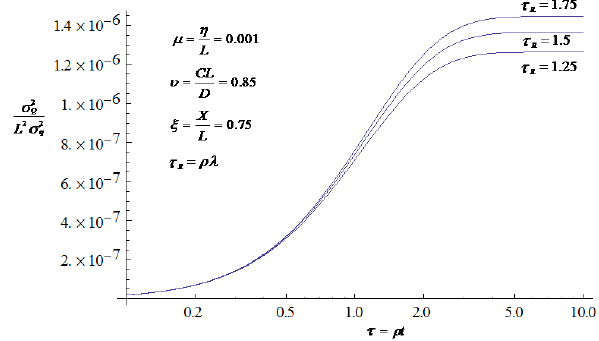
Figure 2. Dimensionless variance of discharge fluctuations as a function of dimensionless time for various dimensionless temporal correlation scales of inflow rate